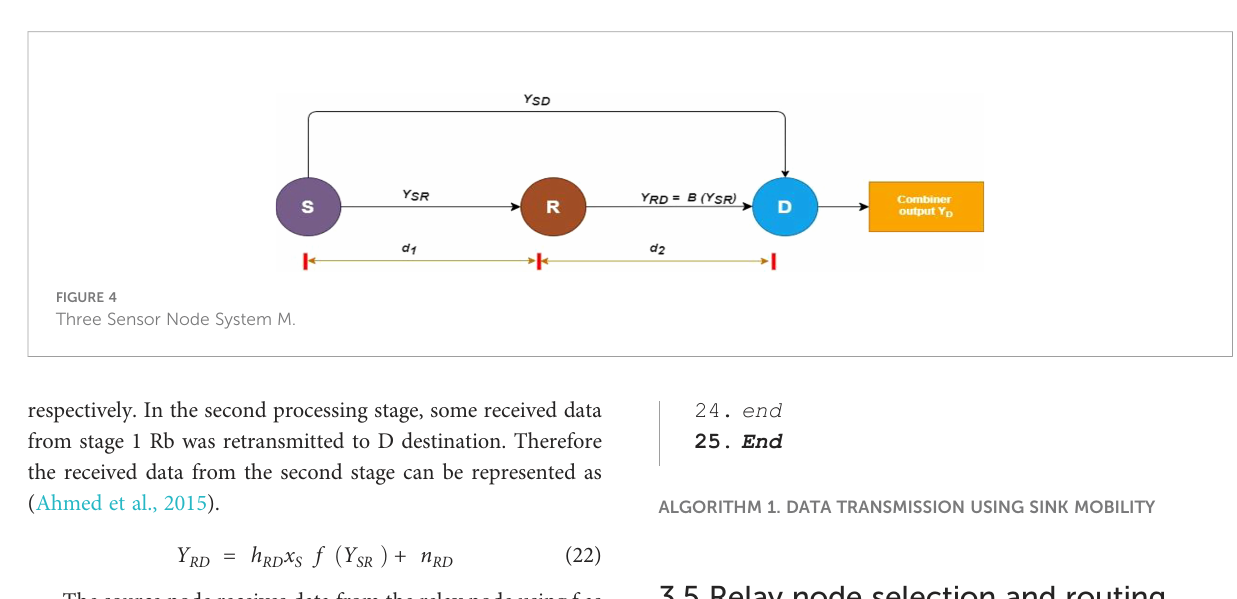
ALGORITHM 1. DATA TRANSMISSION USING SINK MOBILITY